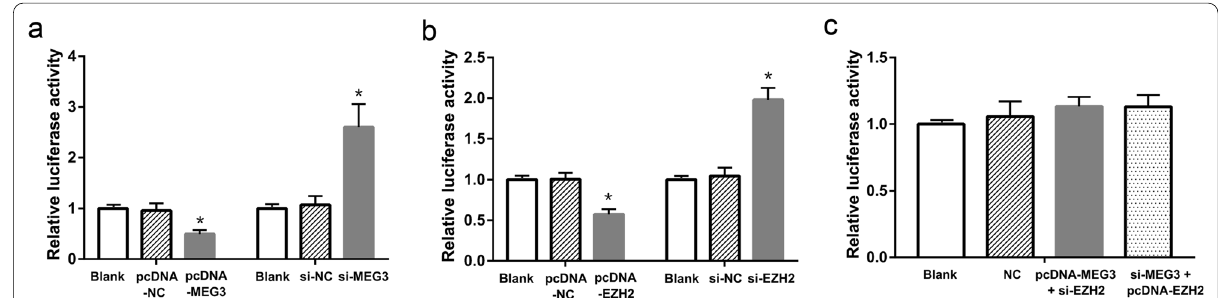
Fig. 6 MEG3 decreased the RASA1 reporter activity via EZH2. Dual-luciferase reporter assay: a Effects of MEG3 on the luciferase activity of the RASA1 -WT dual luciferase reporter. b Effects of EZH2 on the luciferase activity of the RASA1 -WT dual luciferase reporter. c EZH2-mediated effects of MEG3 on the luciferase activity of the RASA1 -WT dual luciferase reporter. *P <